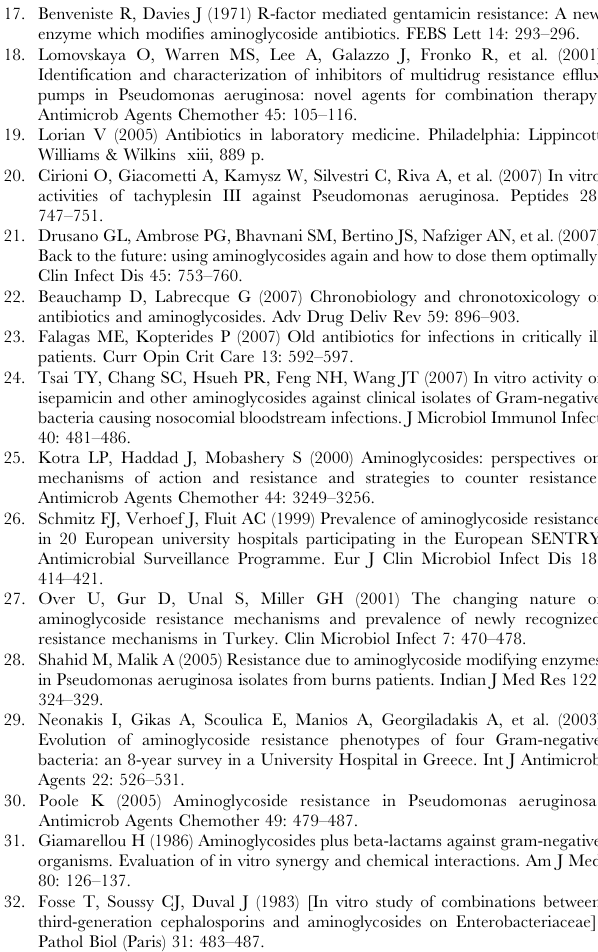
Number of isolates (%)